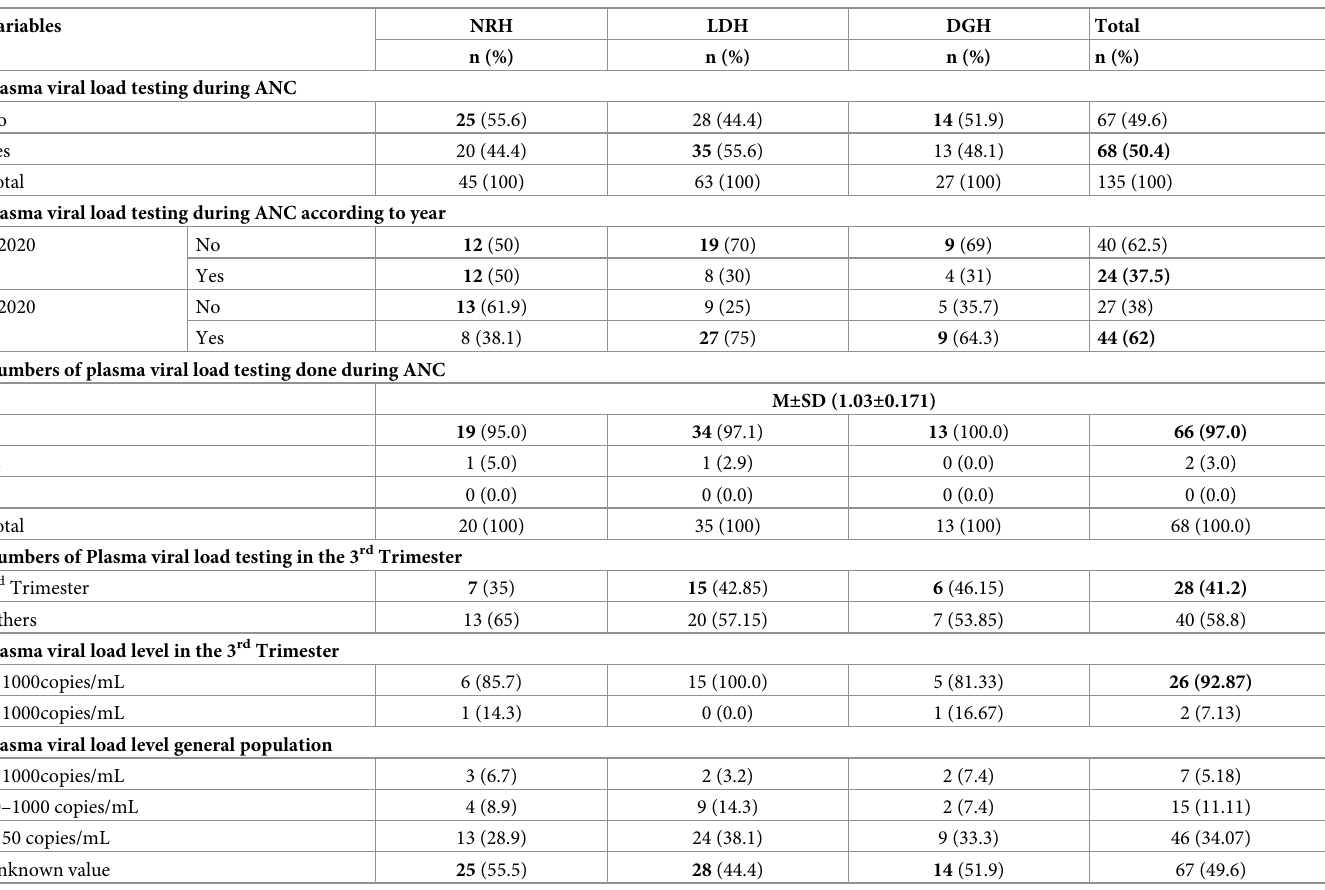
Table 4. Evaluation of plasma viral load coverage among HIV-infected pregnant women.